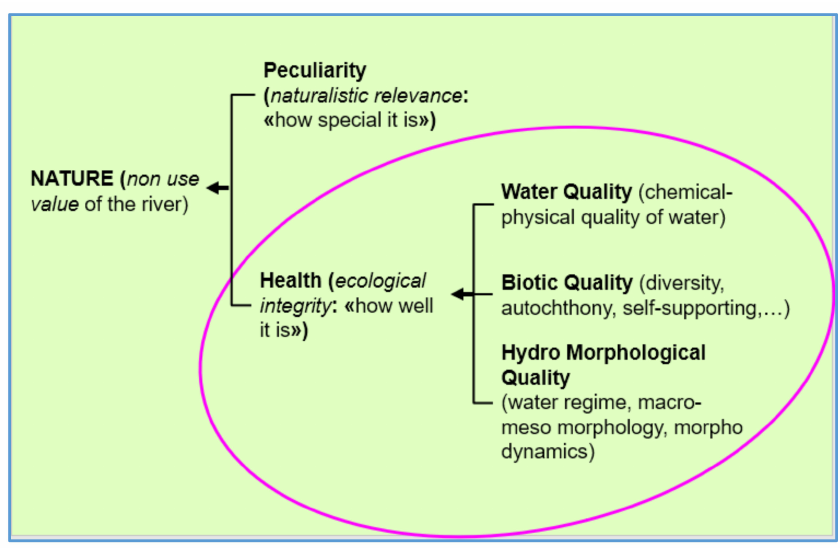
Figure 4. The non-use value tree for a fluvial ecosystem: in addition to “how well it is” ( health ), we must also consider “how special it is” (its peculiarity or naturalistic relevance